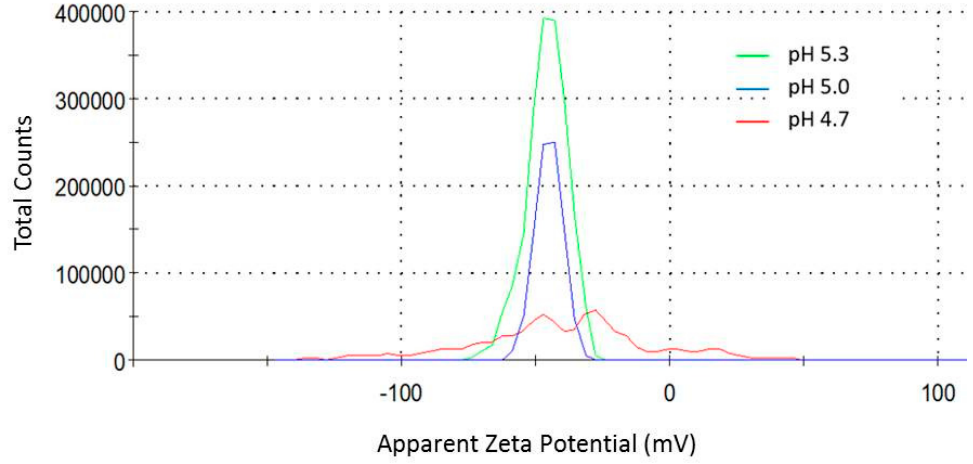
Figure 5. Zeta potential distribution (mV) of citrate-capped AuNPs synthesized at pH 4.7 (red), 5.0 (blue), and 5.3 (green).